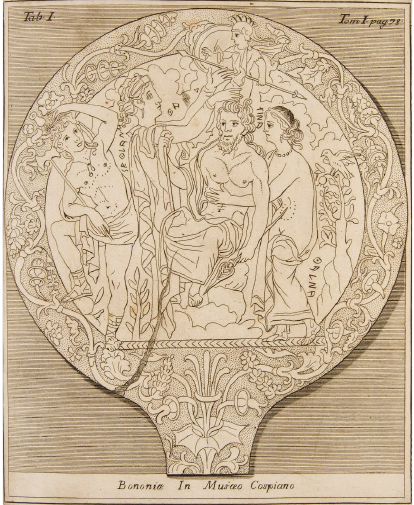
Figure 11. Sarcophagus with the Triumph of Dionysus, 190 CE ca. From wikicommons. Even more interesting is an Etruscan mirror depicting the birth of Athena (Arezzo, middle of the 4th century BCE. Fig. 12). The influence of Greek models is evident. Again, the position is that of women in labour. Intrestingly, there is a midwife who bears him behind his back, pushing on his belly… which, of course, is completely useless, since he is delivering from his head!65